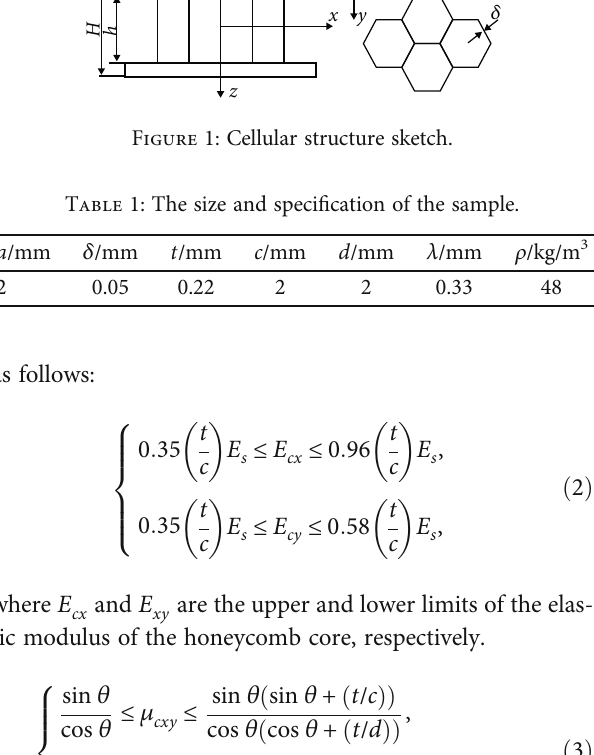
Table 2: Main material performance parameters.